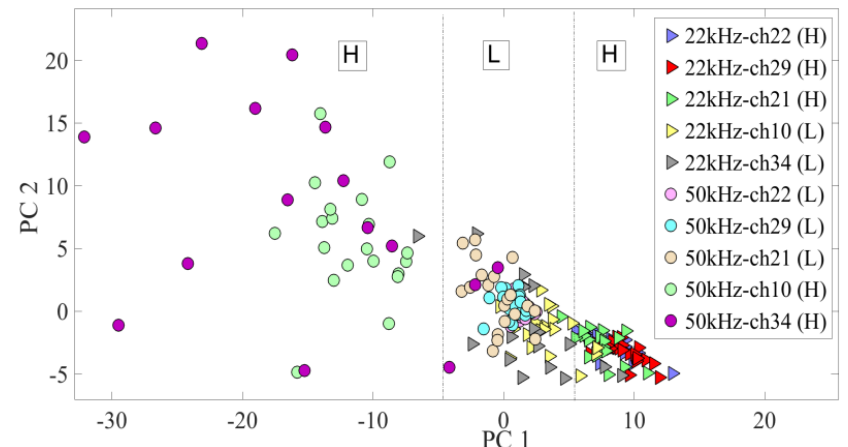
Figure 8. Functional grouping obtained with the PCA technique in response to USVs at 22 kHz and 50 kHz, each one presented 20 times. The PCA matrix was developed by taking into account 5 channels with the highest and lowest sensitivity indices ( SI ). H indicates the highest SI (channels 21, 22, and 29 for 22 kHz (triangles), and channels 10 and 34 for 50 kHz (circles)). Contrarily, L indicates the lowest SI (channels 10 and 34 for 22 kHz (triangles), and channels 21, 22, and 29 for 50 kHz (circles)). PCA classified the H band at the right and the left of the plot for the two different stimuli, in contrast to the L range at the center for both vocalizations.